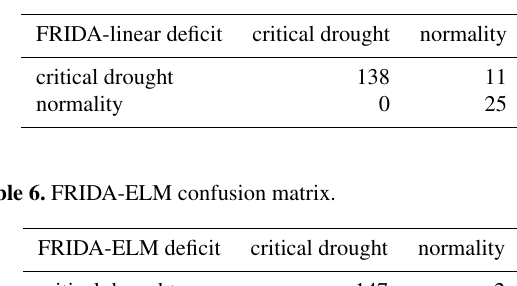
Table 5. FRIDA-linear confusion matrix.